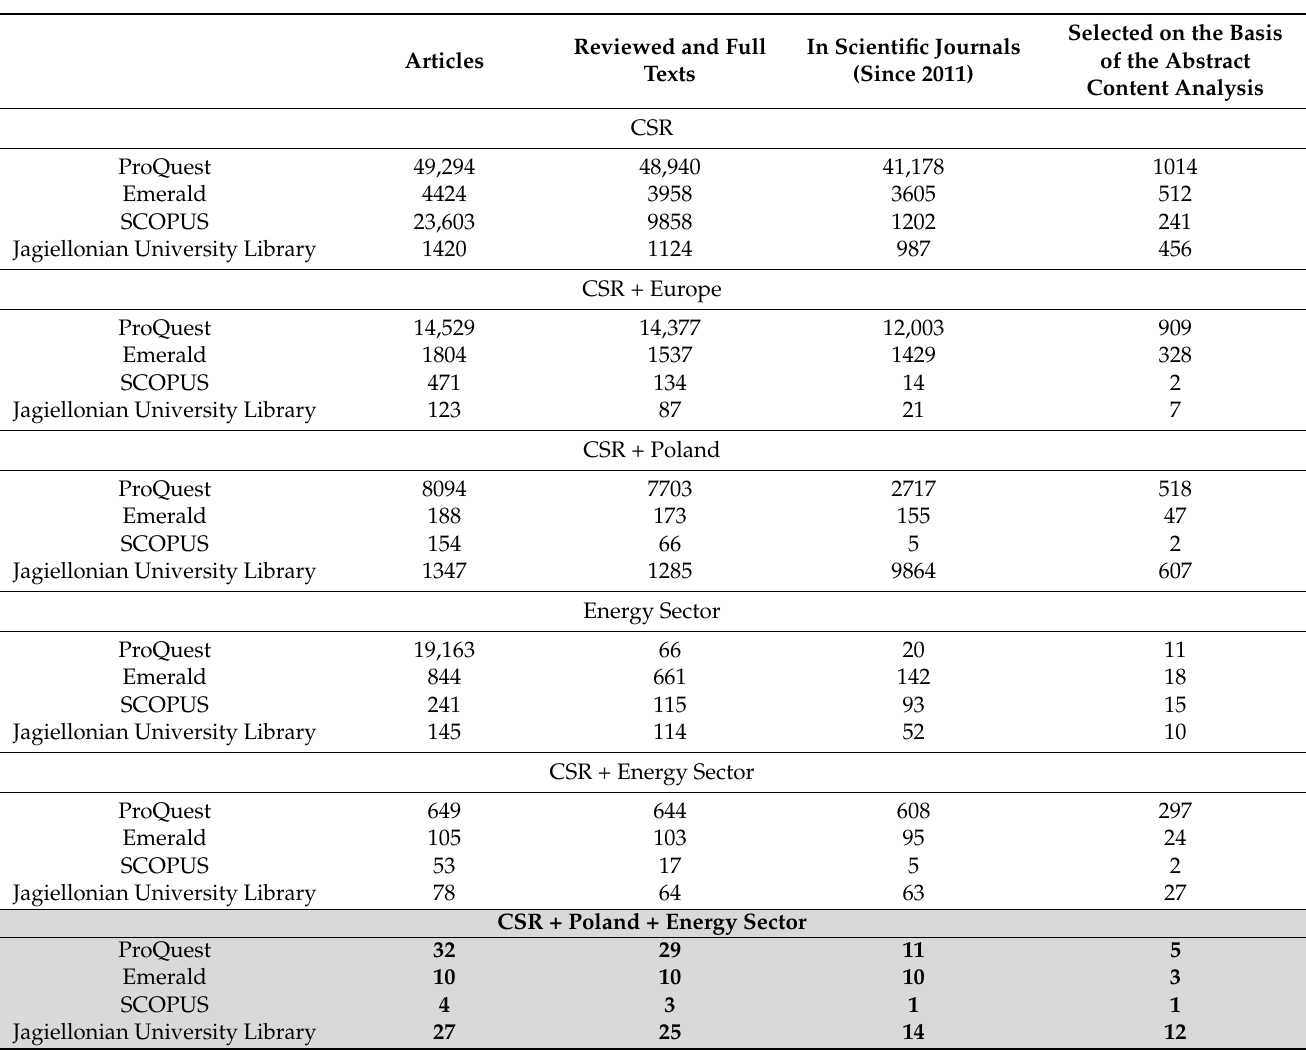
Table 1. Biometric analysis based on